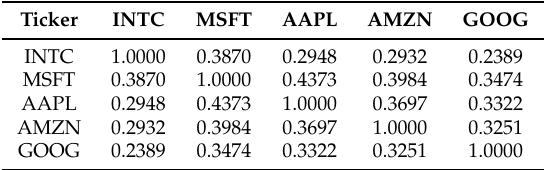
Table 3. Correlations of price increments between 5 stocks. We set the time step as 10